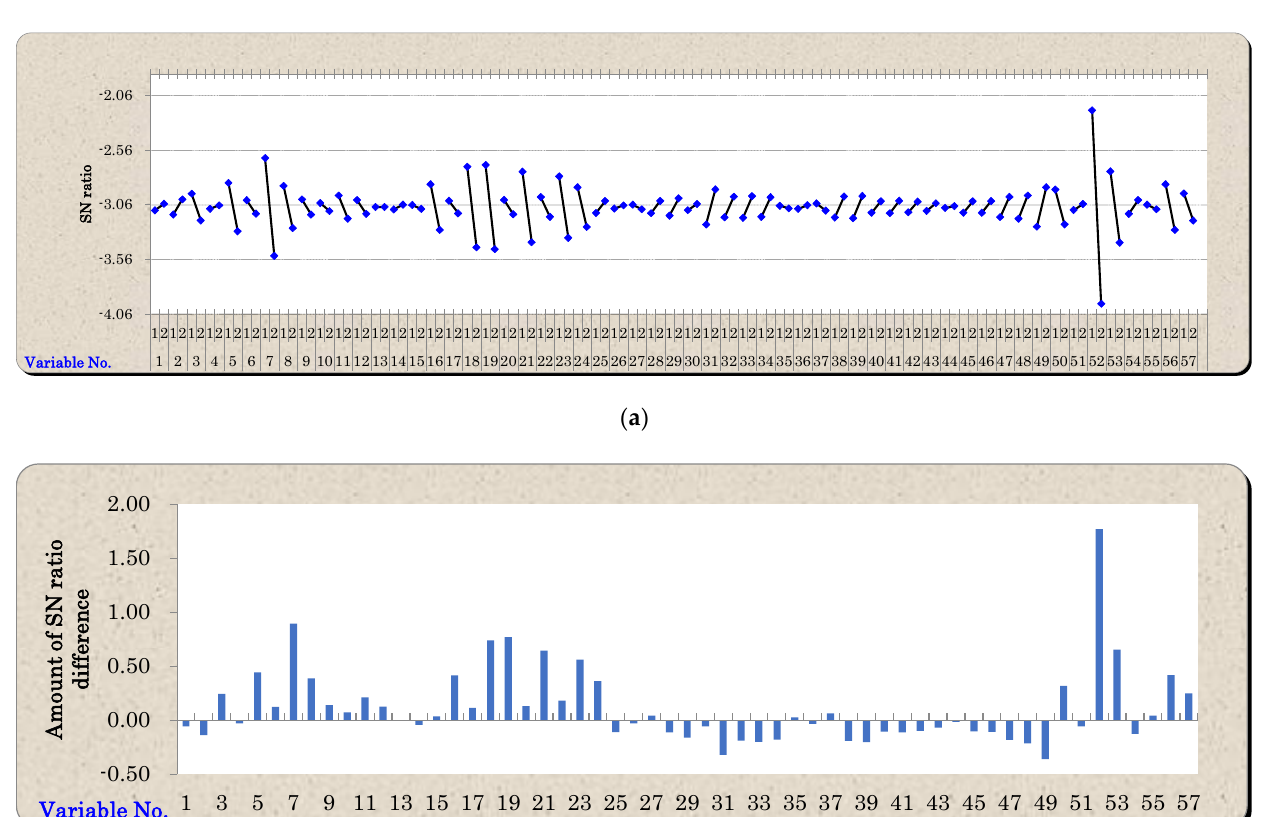
Figure 10. ( a ) SNR Plot and ( b ) SNR Gain Chart for Spambase dataset.